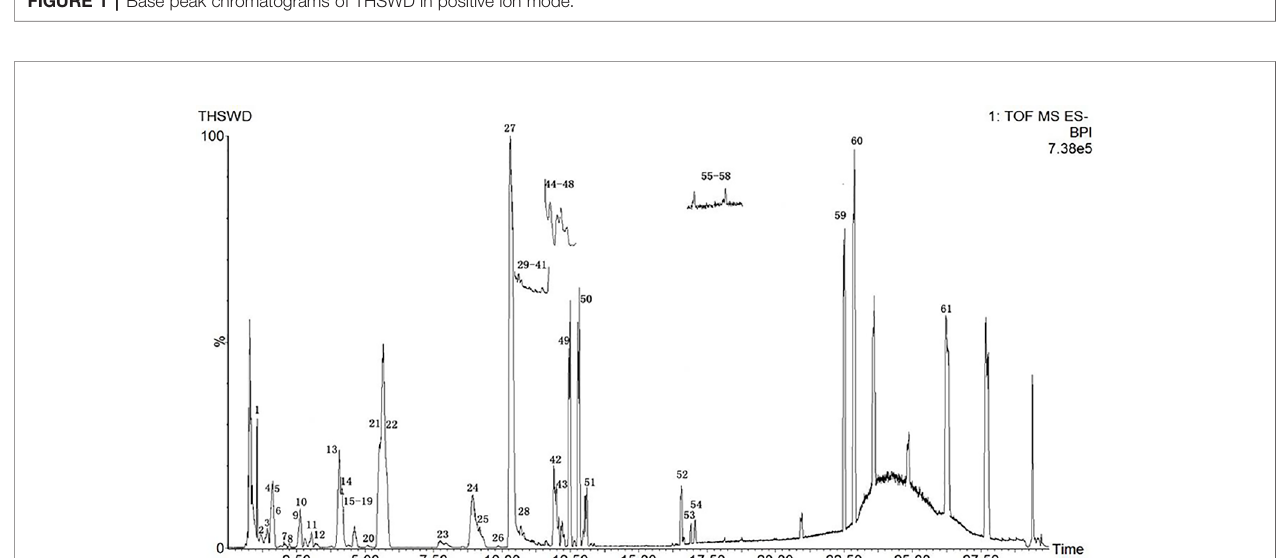
FIGURE 1 | Base peak chromatograms of THSWD in positive ion mode.